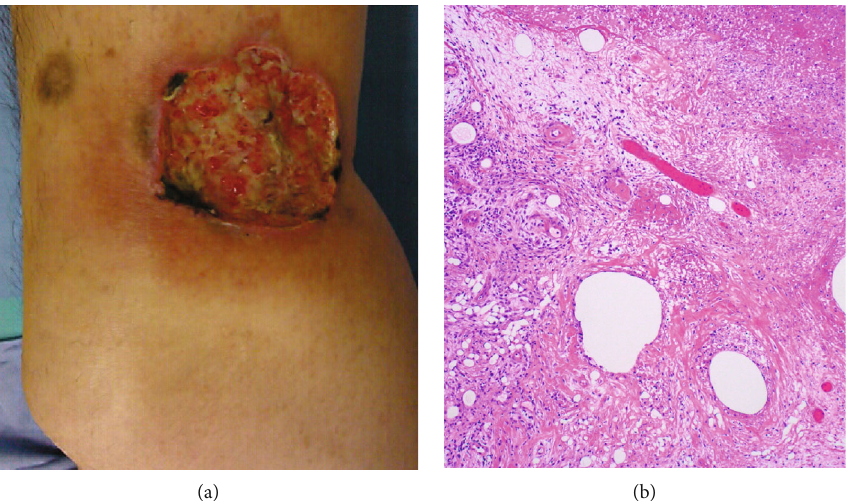
Figure 1: Pyoderma gangrenosum ((a) gross appearance of left lower thigh, (b) H&E). A demarcated deep ulcer, 4 cm in size, is observed. Fibrinous exudation is seen at the ulcer base, and erythematous change is associated around the ulcer (a). Microscopic features of the fi rst biopsy specimen are nonspeci fi c. Ulcer base is composed of fi brinous exudation and granulation tissue (b). Neither granulomatous reactions nor infectious agents are identi fi ed.